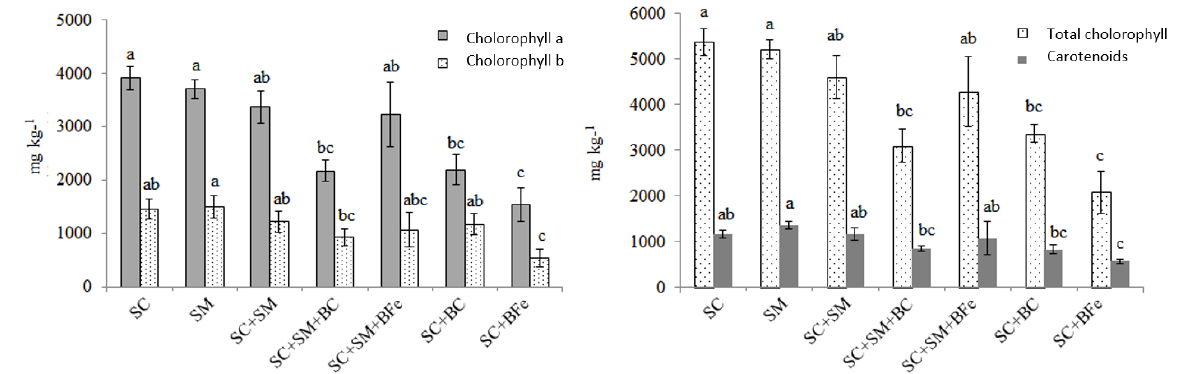
Figure 5. Chlorophyll a, b and total, and carotenoids content after experiment in different treatments. Means followed by the same letter above the bars do not differ statistically from each other by the Tukey test ( p < 0.05), n = 4. Values with the same letter are not significant by the Tukey test ( p < 0.05). SC = contaminated soil, SM = forest soil, SC + SM = contaminated soil + forest soil, SC + SM + BC = contaminated soil + forest soil + biochar, SC + SM + BFe = contaminated soil + forest soil + biochar Fe impregnated, SC + BC = contaminated soil + biochar, SC + BFe = contaminated soil + biochar Fe impregnated. Mean values with standard deviation bars.